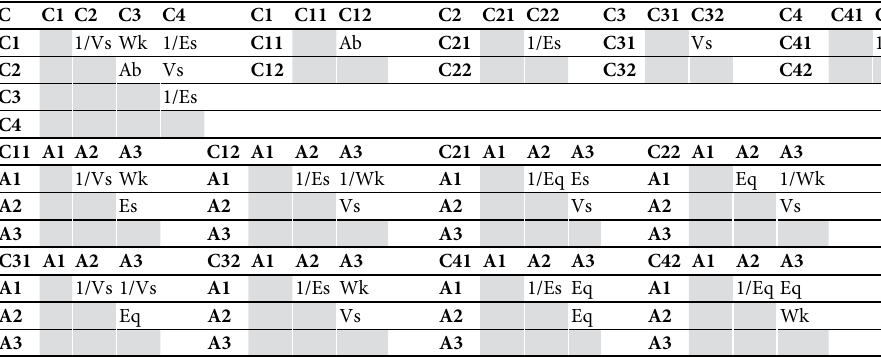
Table A3. Pairwise matrices of Expert